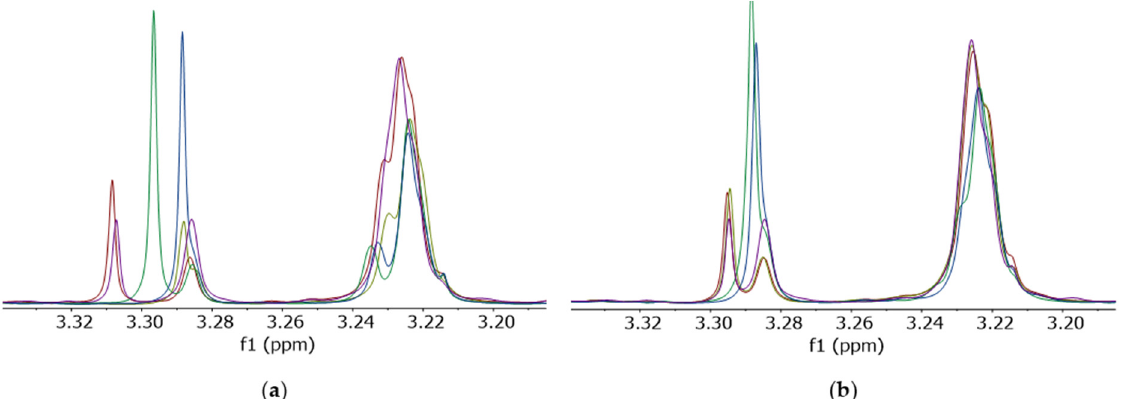
Figure 4. Superposition of five spectra in the range of δ H = 3.21–3.33 ppm of fat extracts from trout samples. ( a ) Solvent was untreated (D 1 )chloroform and (D 4 )methanol (2/1, v / v ) and ( b ) mitigated